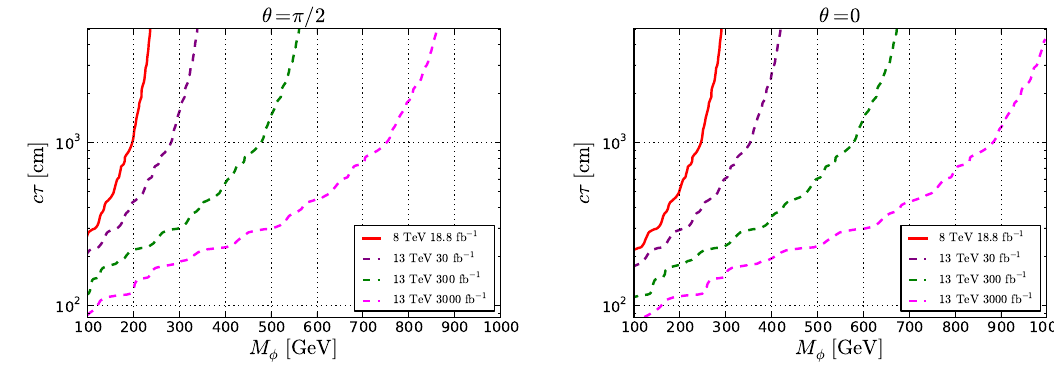
Figure 15 . The 8 TeV (solid) and projected 13 TeV (dashed) limits from HSCP searches at the LHC for pair-production of the scalar co-annihilation partner, (cid:30) (cid:6) . The projected limits correspond to the 13 TeV LHC with 30, 300 and 3000 fb (cid:0) 1 integrated luminosities.